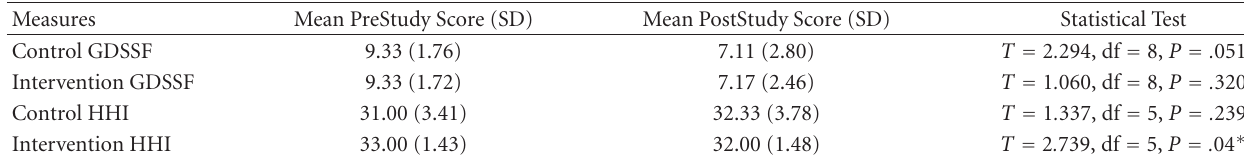
Table 2: Scores of control and intervention groups, and within-group